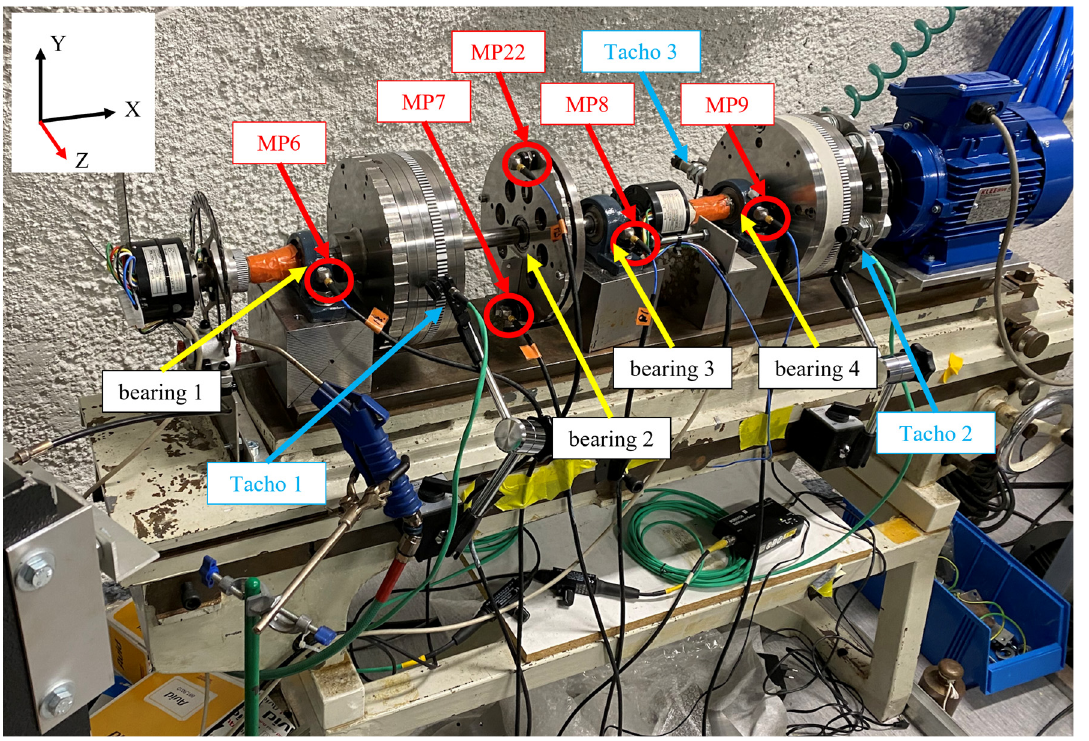
Figure 5. Experimental setup and sensor location. Acceleration measurement points: MP6 (bearing 1), MP7 (disk 2, lower, near support), MP8 (bearing 3), MP9 (bearing 4), and MP22 (disk 2, upper, top of the disk).